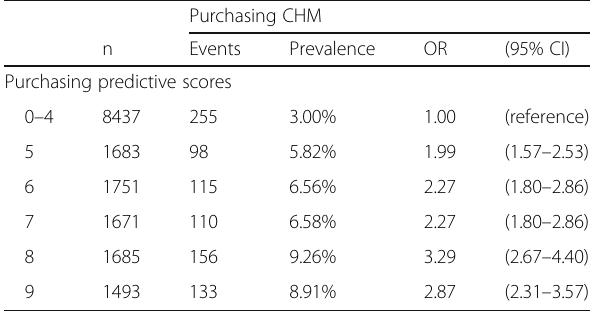
Table 4 Predictive scores of purchasing CHM without physician ’